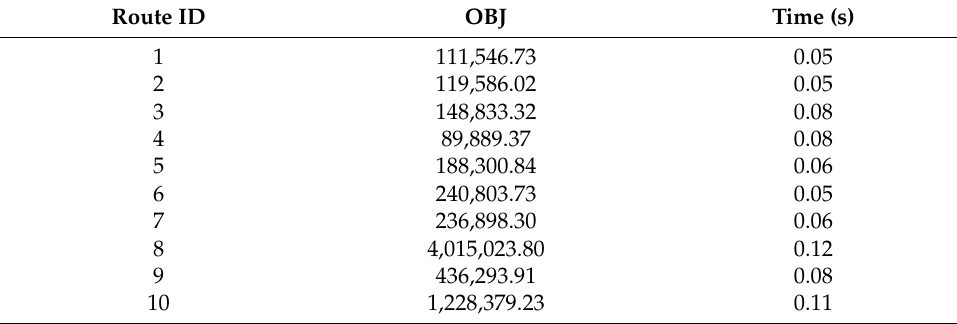
Table 2. Computational results of the basic